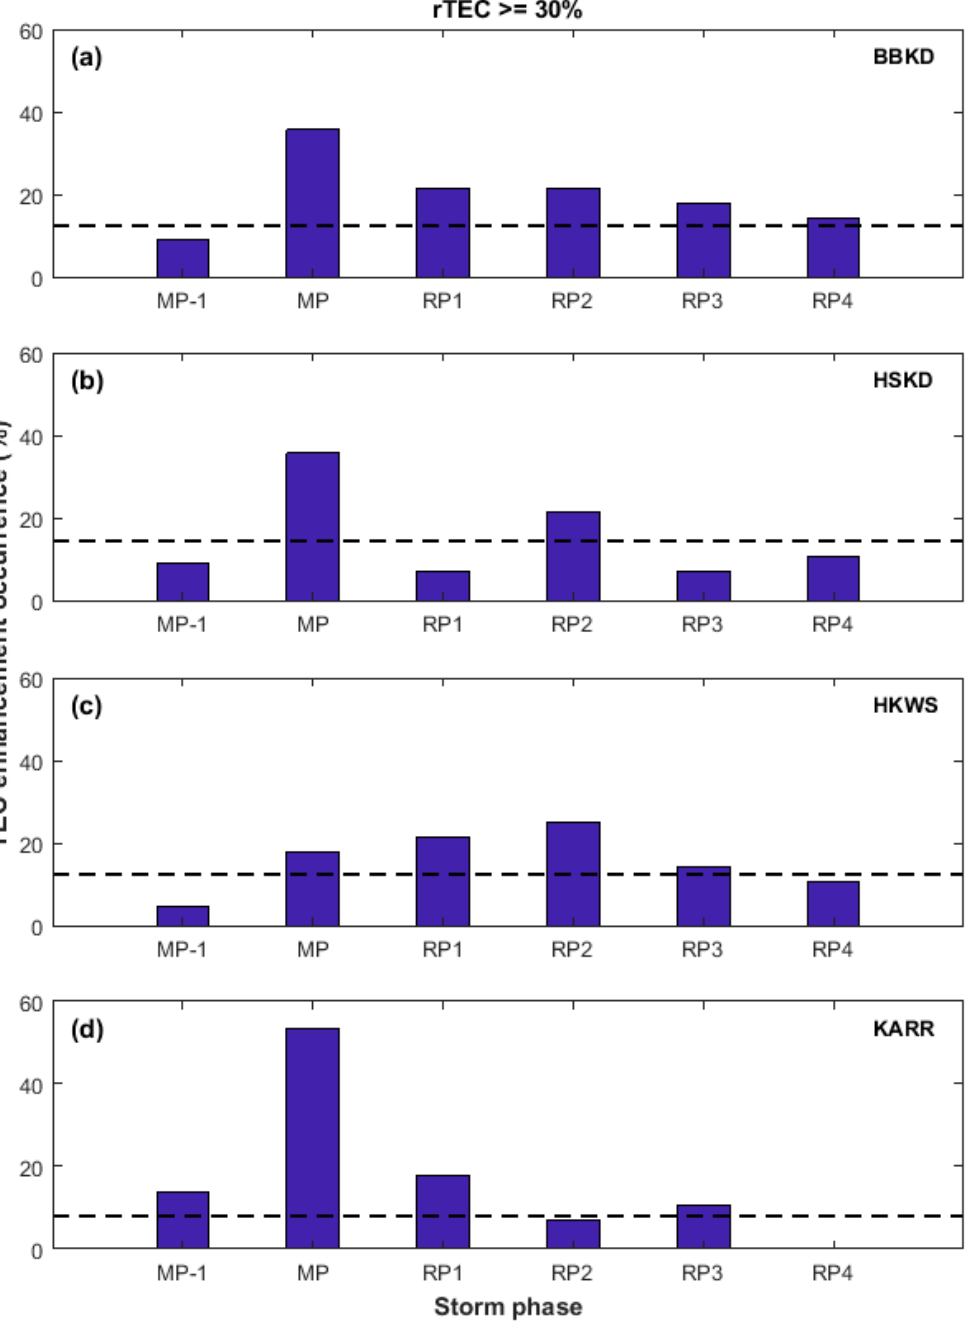
Figure 8. ( a – d ) The occurrence of TEC enhancements variation with geomagnetic storm phases: the initial phase (MP-1), main phase (MP), and recovery phases; RP1, RP2, RP3, and RP4, denoting 1st, 2nd, 3rd, and 4th day after the main phase respectively. The horizontal dashed lines show the baselines for TEC enhancements under Kp < 3 condition.